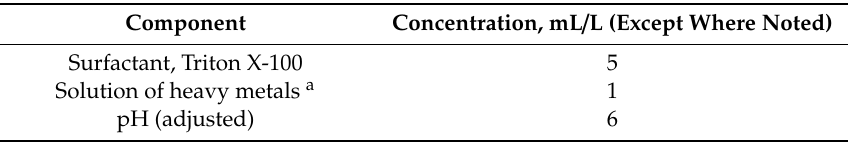
Table 2. The composition of synthetic leachate used in the laboratory.